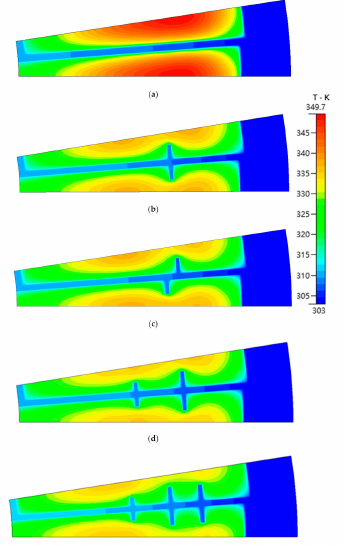
Figure 8. The comparisons of temperature distributions for ( a ) PTHE-Z, ( b ) design A ( c ) design B ( d ) design C and ( e ) design D at z = 100